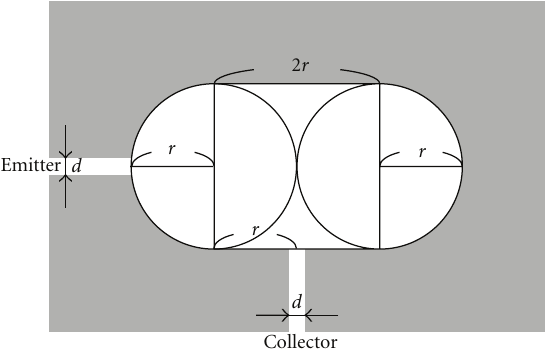
Figure 20: A stadium-shaped quantum dot with an emitter and a